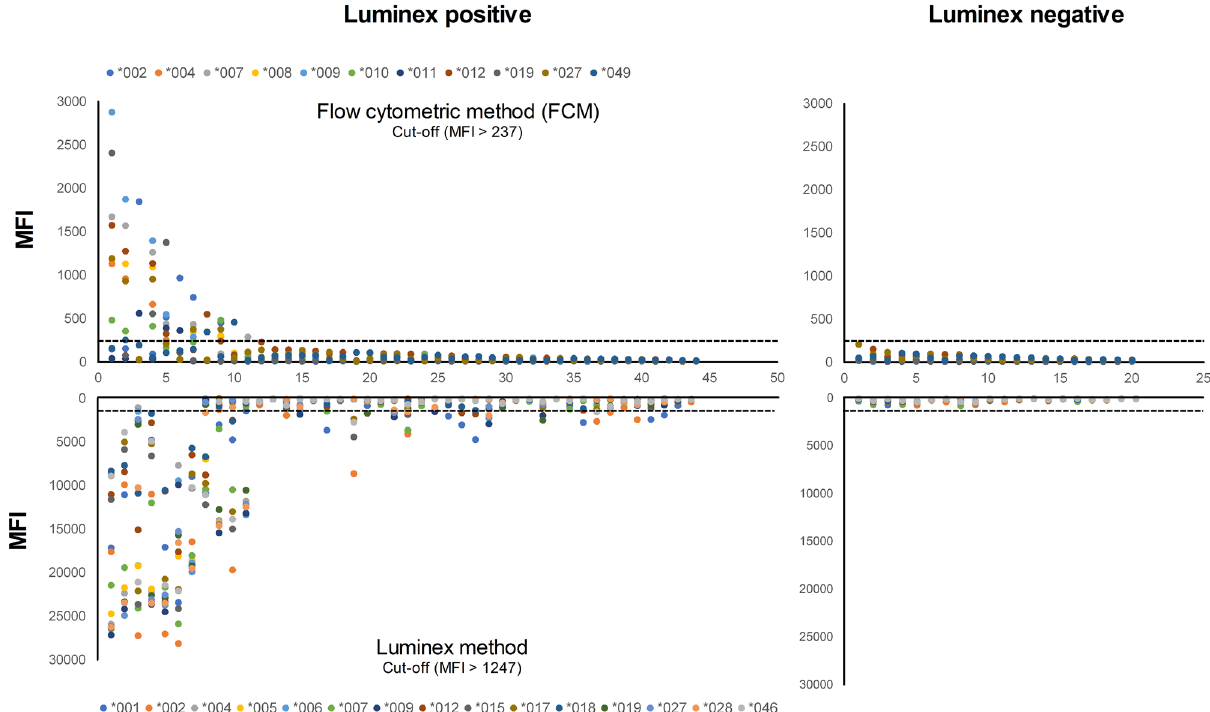
Figure 3. Comparison of response patterns to each MICA allele by flow cytometric method (FCM) and Luminex method using sera of kidney transplant patients (n = 64). Results were displayed in the order of sera with weak response to strong response. As for the Luminex method, 33 sera with a response of 1247 MFI or higher were determined as positive, and, as for the FCM, 11 sera with a response of 237 MFI or higher were determined as